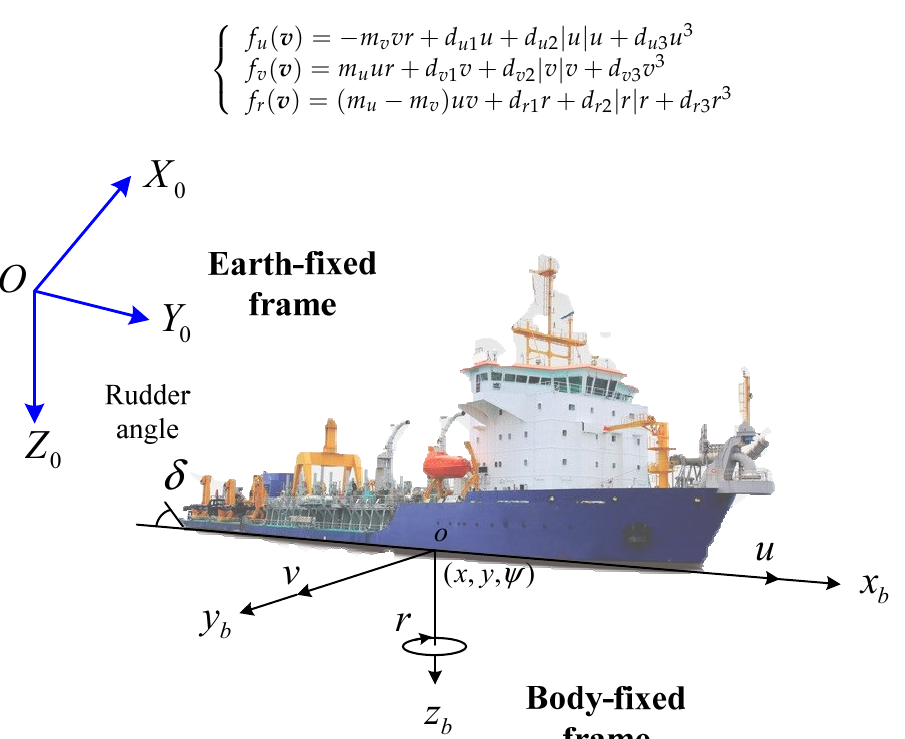
direct control of sway motion. In Figure 1, O − X 0 Y 0 Z 0 denotes the earth-fixed frame, and o − x b y b z b indicates the body-fixed frame. In Equations (1) and (2), η = [ x , y , ψ ] T ∈ R 3 describes the surge, sway and yaw angles for the USV. v = [ u , v , r ] T ∈ R 3 denotes the surge, the sway and the yaw velocity in the body-fixed framework. m u , m v , m r are the unknown parameters used to express the additional mass. d u 1 , d u 2 , d u 3 , d v 1 , d v 2 , d v 3 , d r 1 , d r 2 , d r 3 are used to express the unknown hydrodynamic damping parameters. d wu , d wv and d wr denote the external disturbances caused by the sea wind, current and waves. N , δ denote the system input variables, i.e., the main engine speed and the rudder angle. To facilitate the following control design, one defines N = N , δ = δ . f u ( v ) , f v ( v ) , f r ( v ) are the nonlinear functions, which can be expressed as Equation (3).